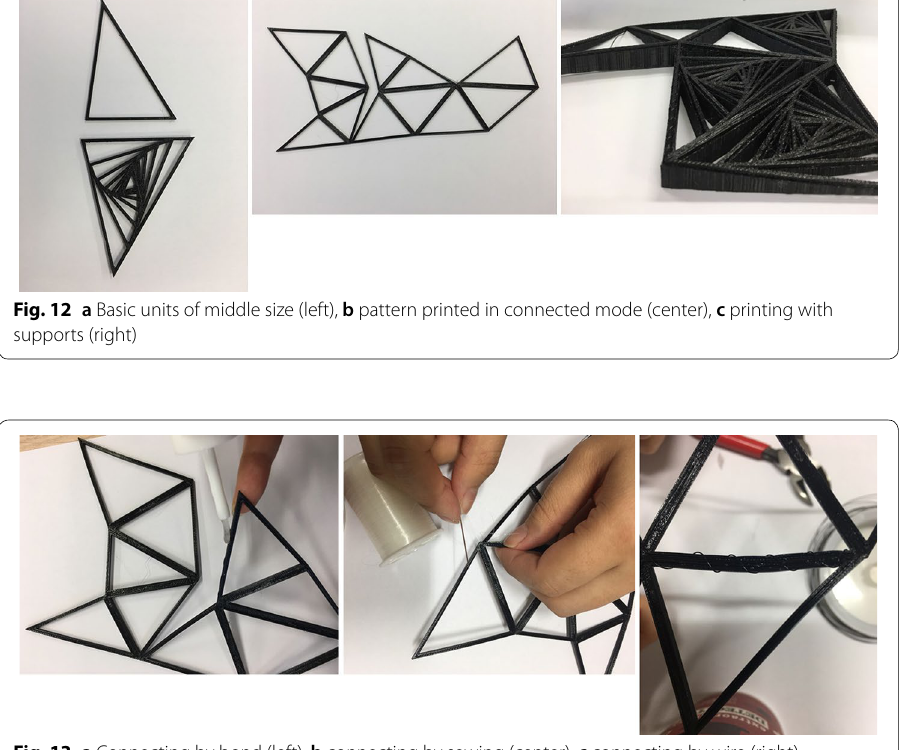
Fig. 13 a Connecting by bond (left), b connecting by sewing (center), c connecting by wire